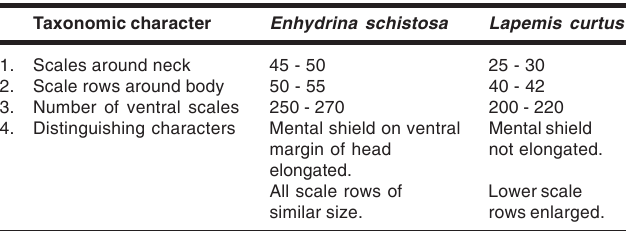
Table 1. Taxonomic characters of sea snakes observed along Goa